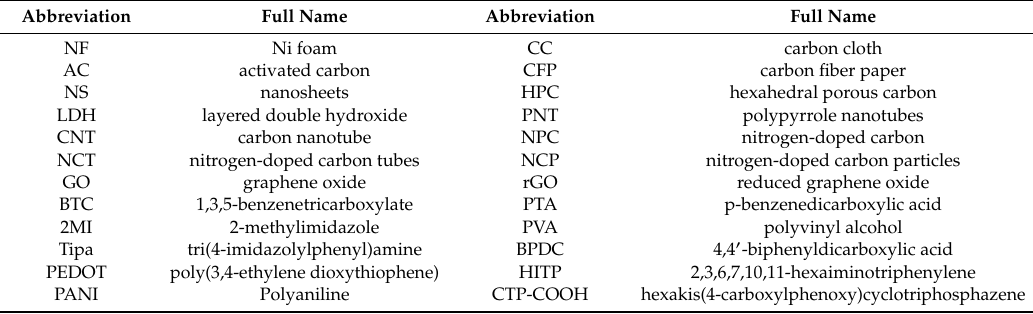
Table A1. The abbreviations and their corresponding full name used in this